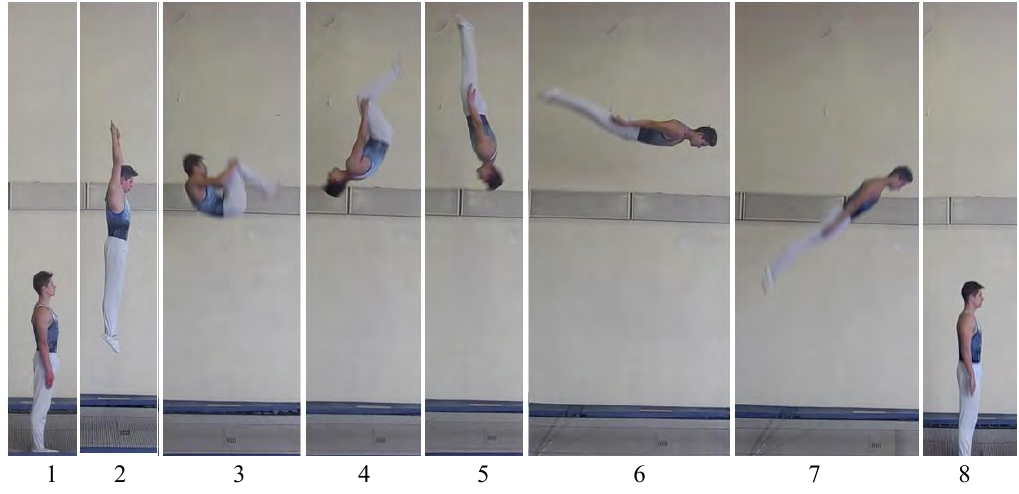
Fig.9. Back somersault Recommendations: fulfill temp jumps (shots 1-2). In tep jumps create backward rotation and grpup